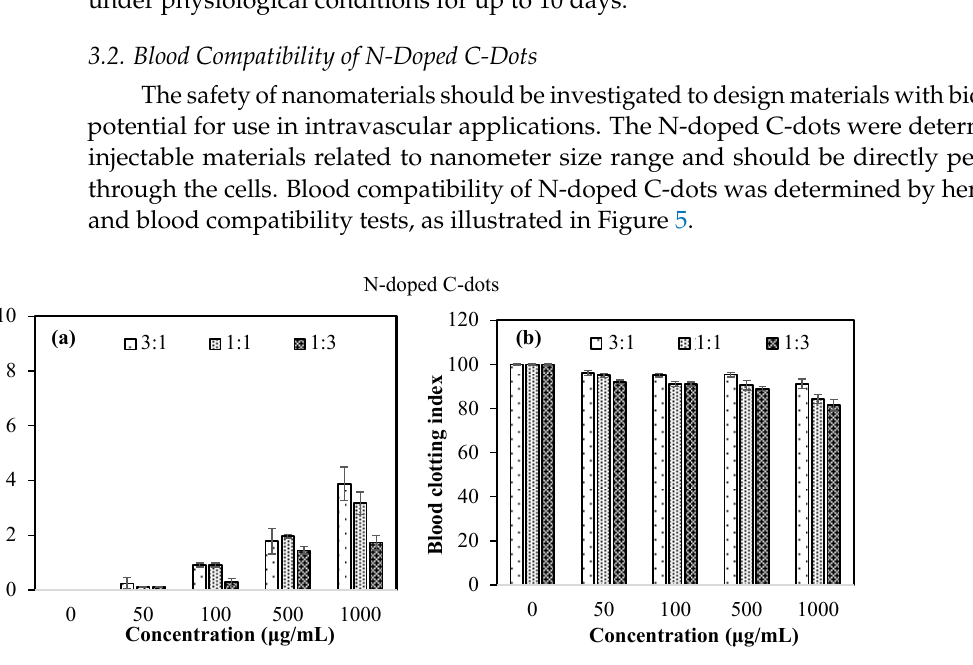
Figure 5. ( a ) Hemolysis and ( b ) blood clotting indexes of N-doped C-dots prepared at 3:1, 1:1, and 1:3 weight ratios of CA:PVAm.